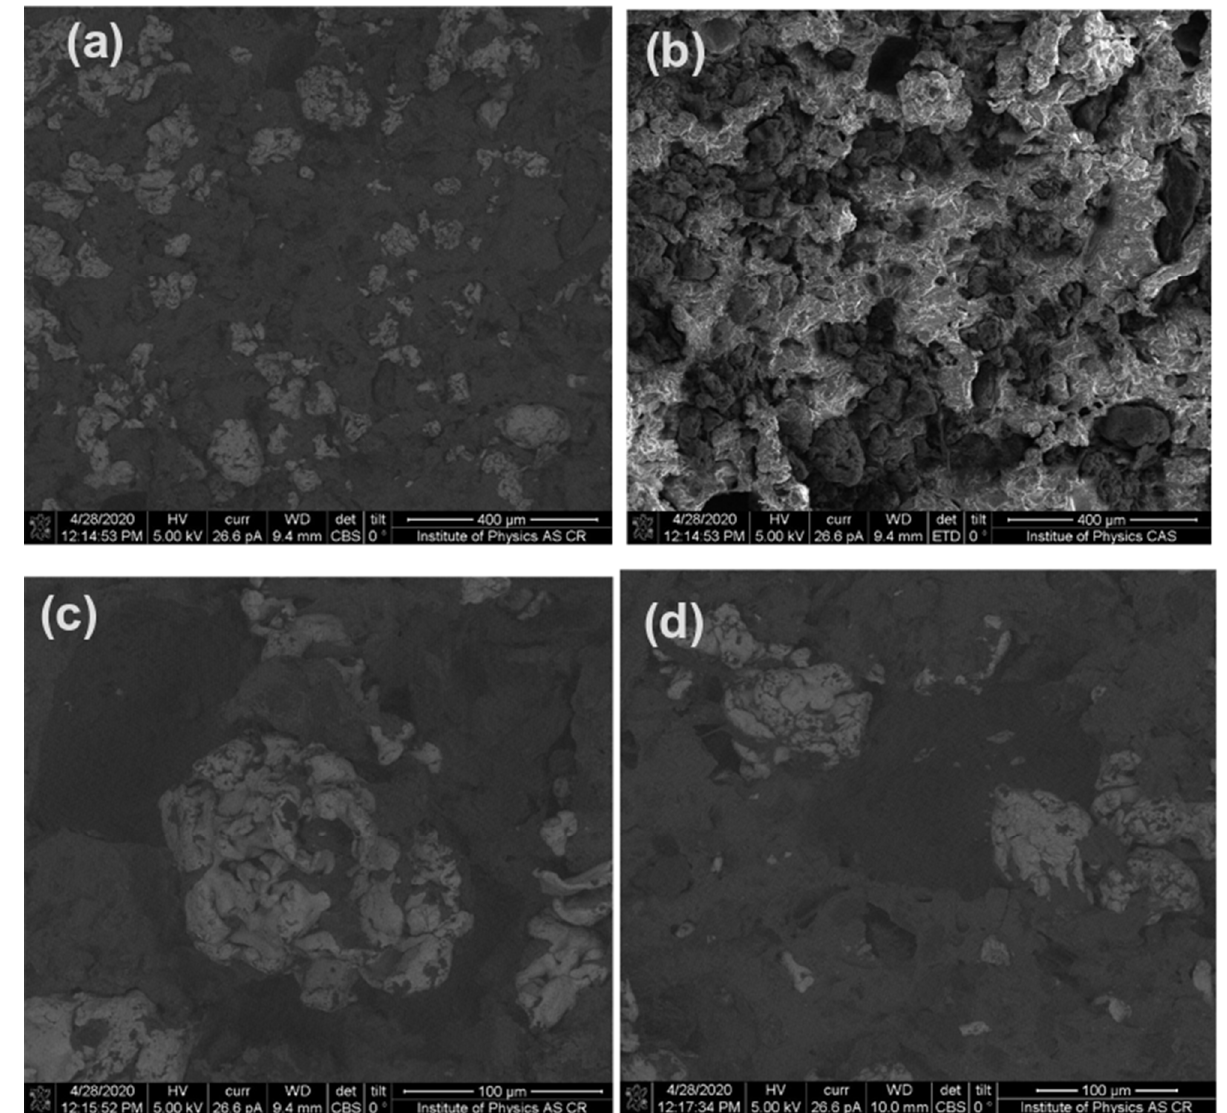
Figure 4. Graphite filler reinforced in polymer matrix shown in ( a ) BSE; and ( b ) SE mode; ( c ) zoom view of enlarged particle shows interfacial adhesion within a polymer matrix; ( d ) another location shows agglomeration of particles with contact surface in polymer matrix.